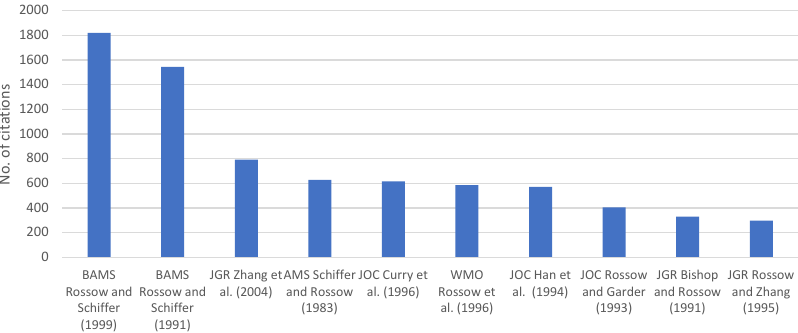
Figure 1. ISCCP ten most cited papers that have contributed to the dataset’s more than 15000 citations. The number of citations given here is based on Google Analytics, accessed February 10,